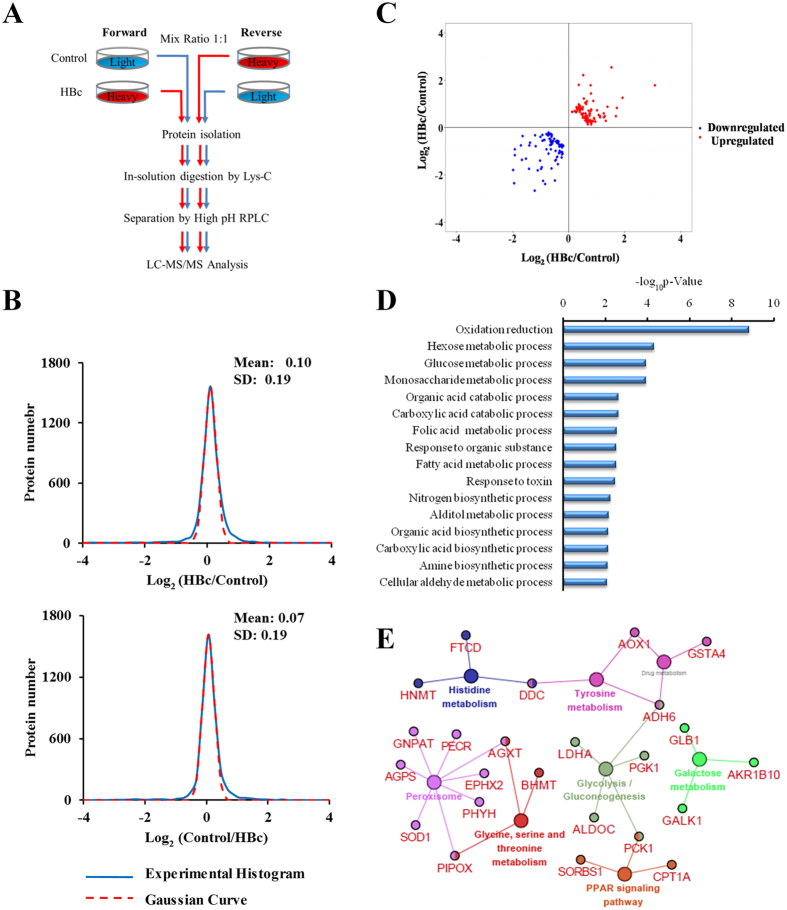
Enzymes that significantly change between HBc and control cells.(A) Workflow of the SILAC-based proteomic identification process with forward and reverse labelling experiments. (B) The quality of SILAC labelling was determined by observing the normalized log2 ratio distribution of the differentially expressed proteins from the forward and reverse datasets. (C) The scatter plot displays the regulated proteins based on the protein expression ratios of HBc and control cells. (D) Functional enrichment analysis of differentially expressed proteins. The y-axis presents the functional categories identified in the GO analysis in terms of biological processes. The x-axis demonstrates the significance (p < 0.05). (E) KEGG annotation revealed the networks up-regulated by HBc. Large nodes represent metabolites within core regulatory networks. Enzymes are represented by small nodes. The results only showed pathways with p < 0.05 and cluster protein number ≥ 3.